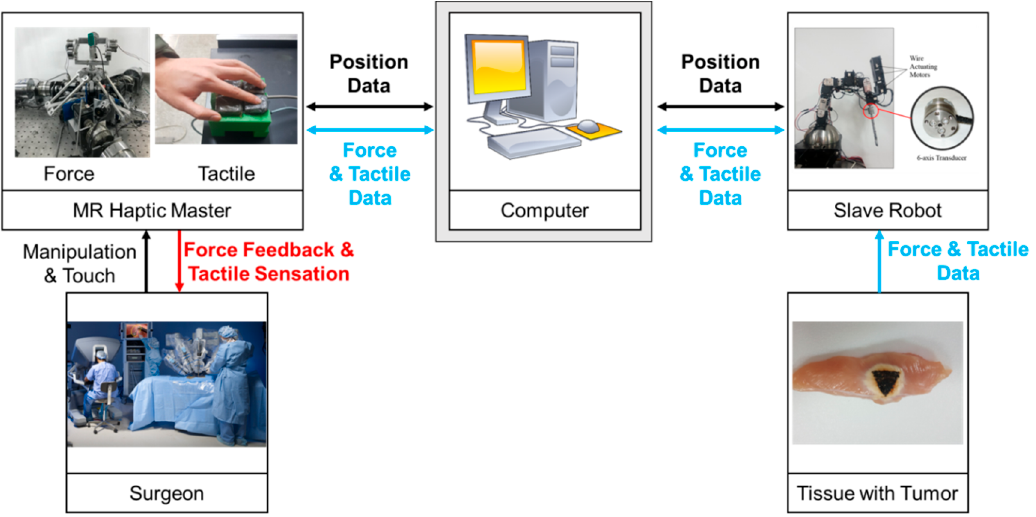
Figure 14. Experimental configuration for the robot surgery integrated with MR haptic master and tactile device.